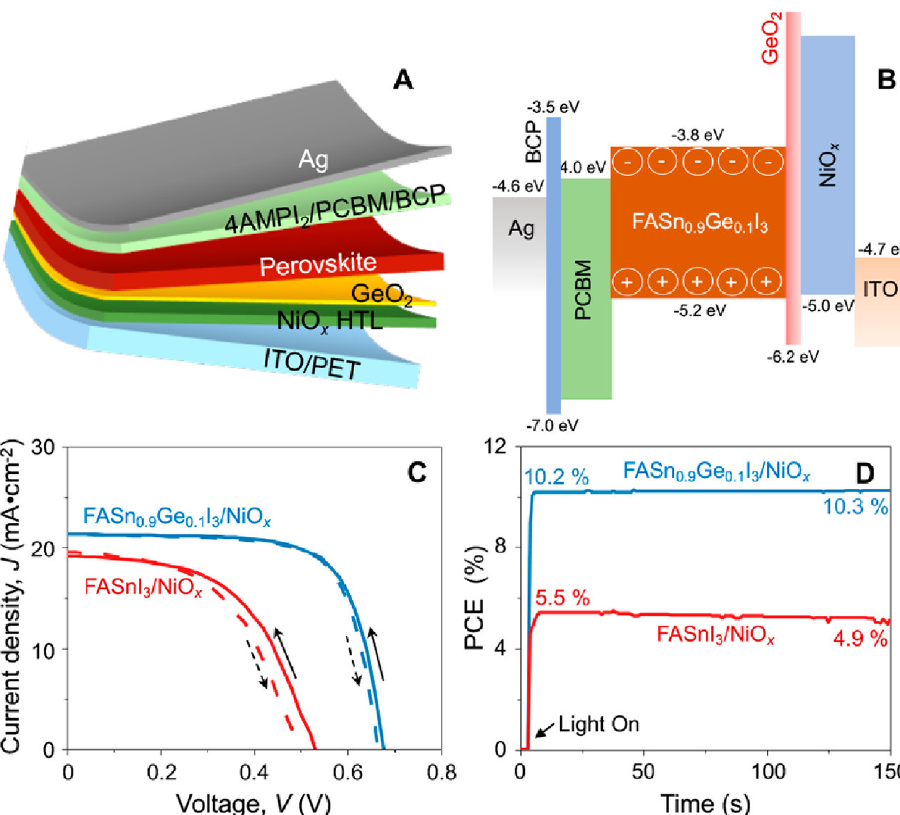
Figure 22. ( A ) Schematic of flexible Sn − PVK solar cells, ( B ) Energy diagram, ( C ) Best J − V characteristics with and without GeO 2 , ( D ) MPPT tracking. Reproduced with permission [77]. Copyright 2022, American Chemical Society.